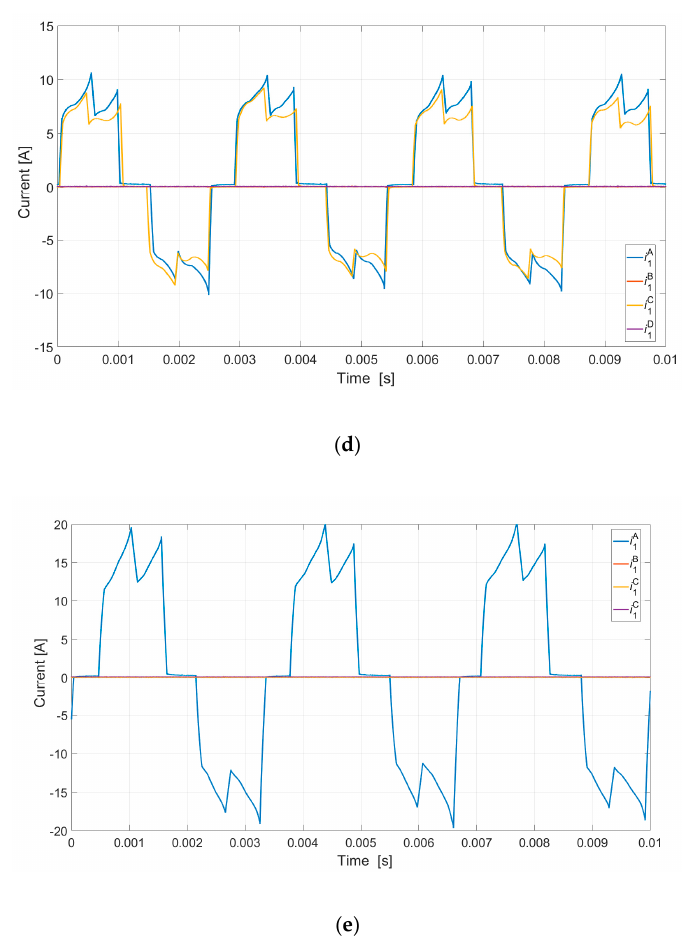
Energies 2019 , 12 , x FOR PEER REVIEW Figure 15. Waveforms of currents for QCO ( a ); TCO ( b ); DCO A and C ( c ); DCO A and B ( d ); and SCO ( e ). Figure 15. Waveforms of currents for QCO ( a ); TCO ( b );DCO A and C ( c ); DCO A and B ( d ); and SCO ( e ).